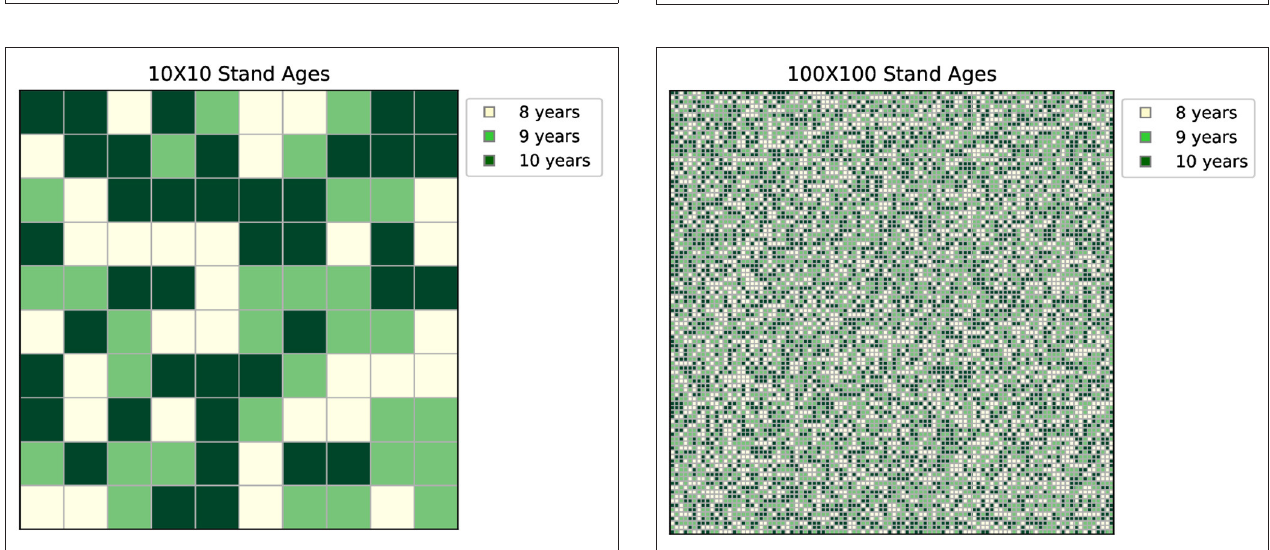
FIGURE 8 | Timber ages for the 100